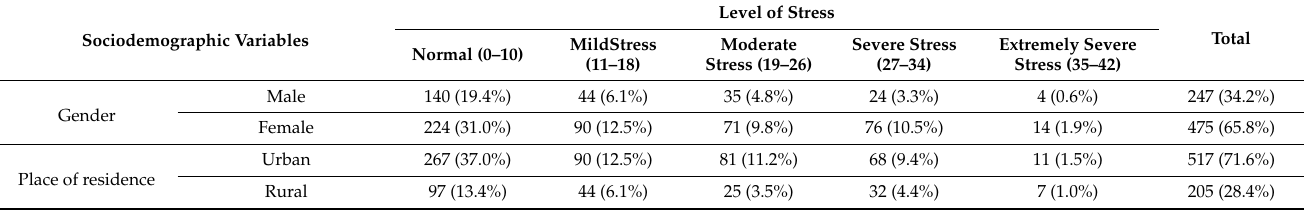
Table 1. Sociodemographic variables distribution depending on level of perceived stress.